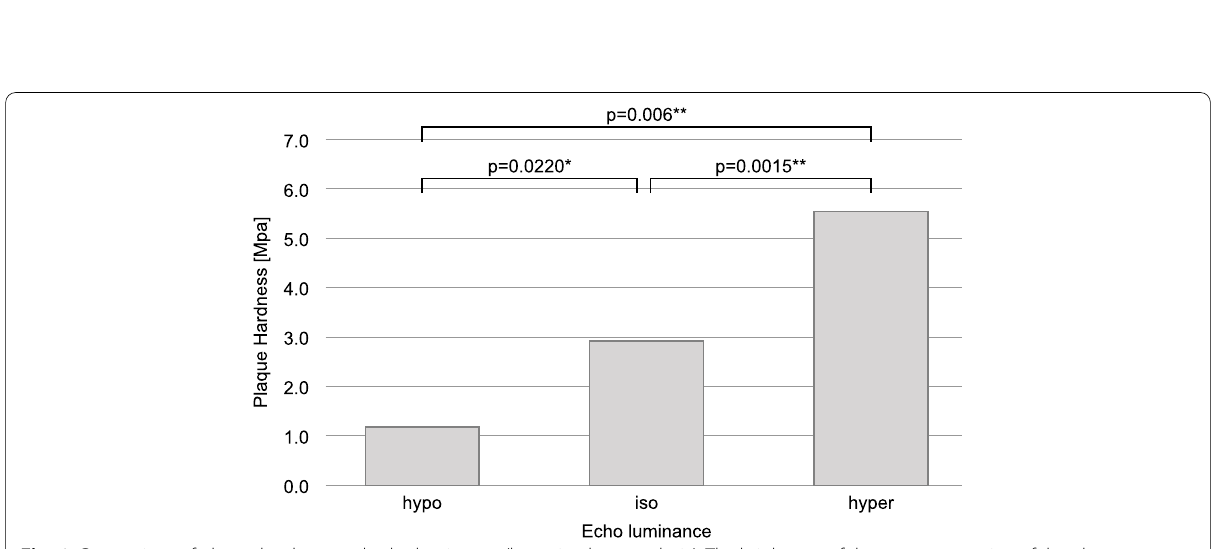
Fig. 6 Comparison of plaque hardness and echo luminance (hypo, iso, hyper-echoic). The brightness of the narrowest region of the plaque was classified as hypo-echoic, isoechoic, or hyper-echoic based on the brightness of the intima-media complex near the